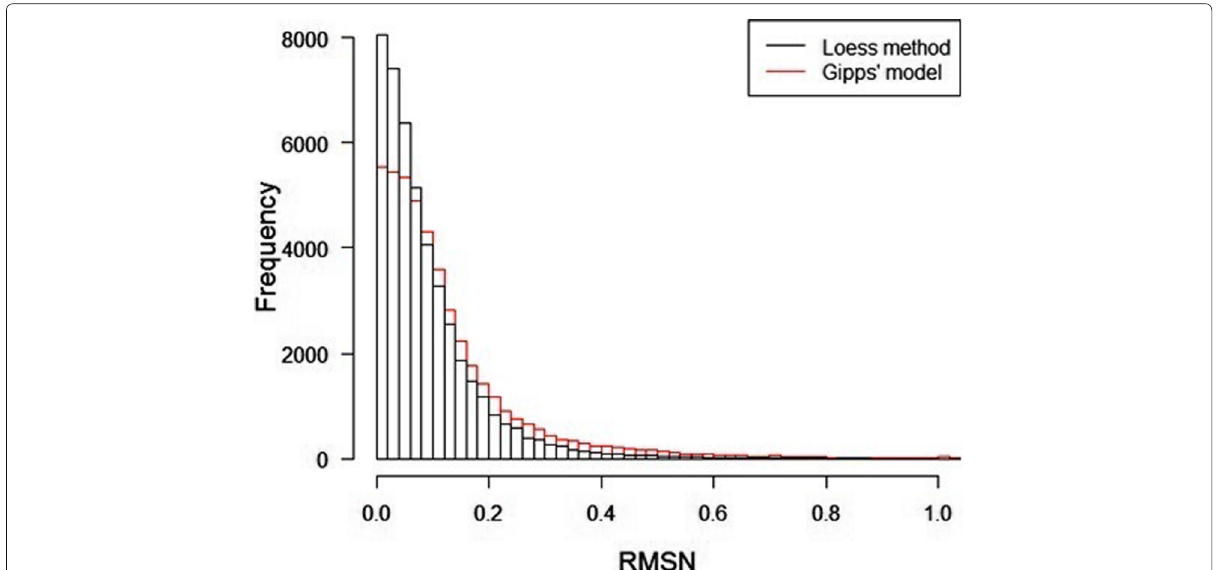
Fig. 6 Histograms of RMSN using loess method and Gipps’ model for dataset